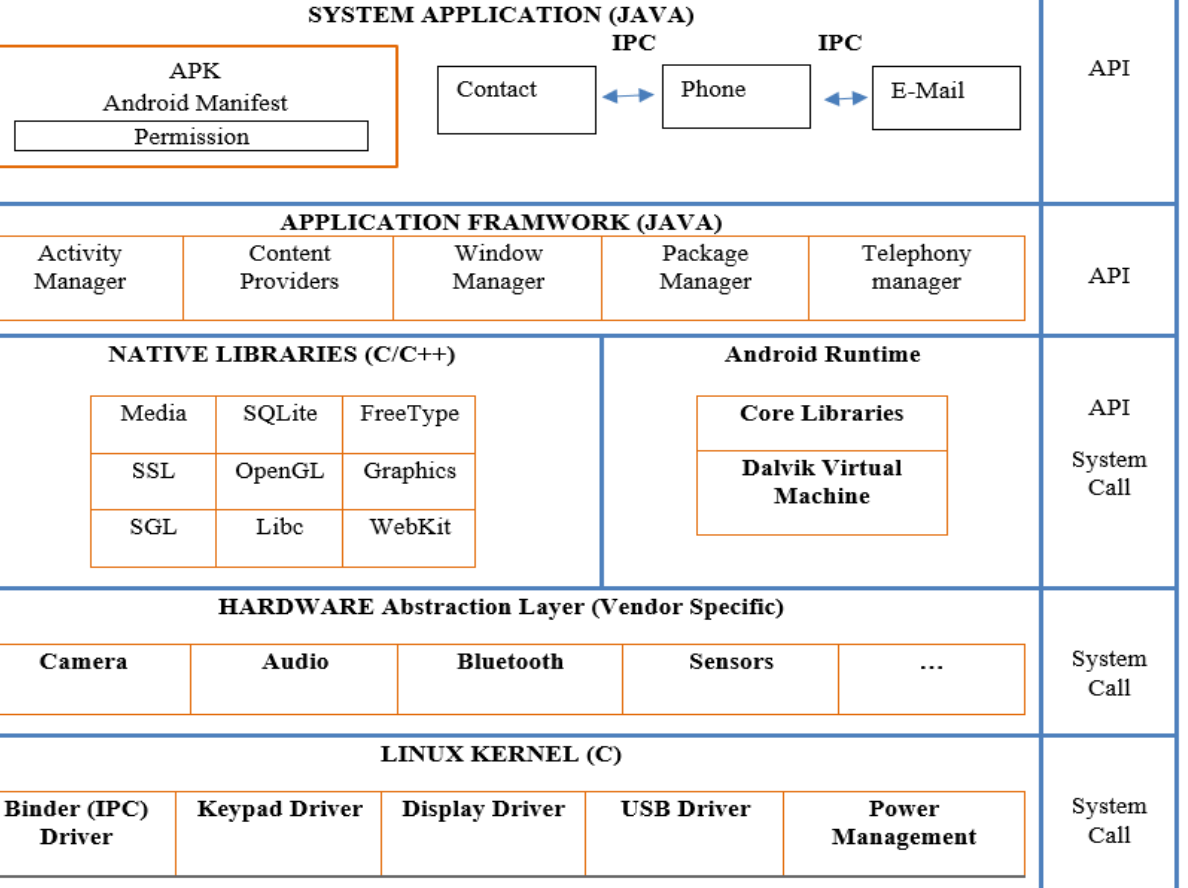
Table 2. Layered attacks on Android Architecture with proposed security measures.